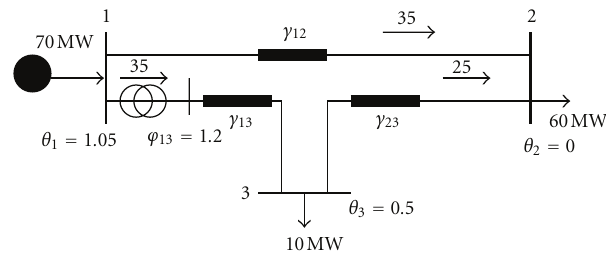
Figure 4: Load flow solution with a phase